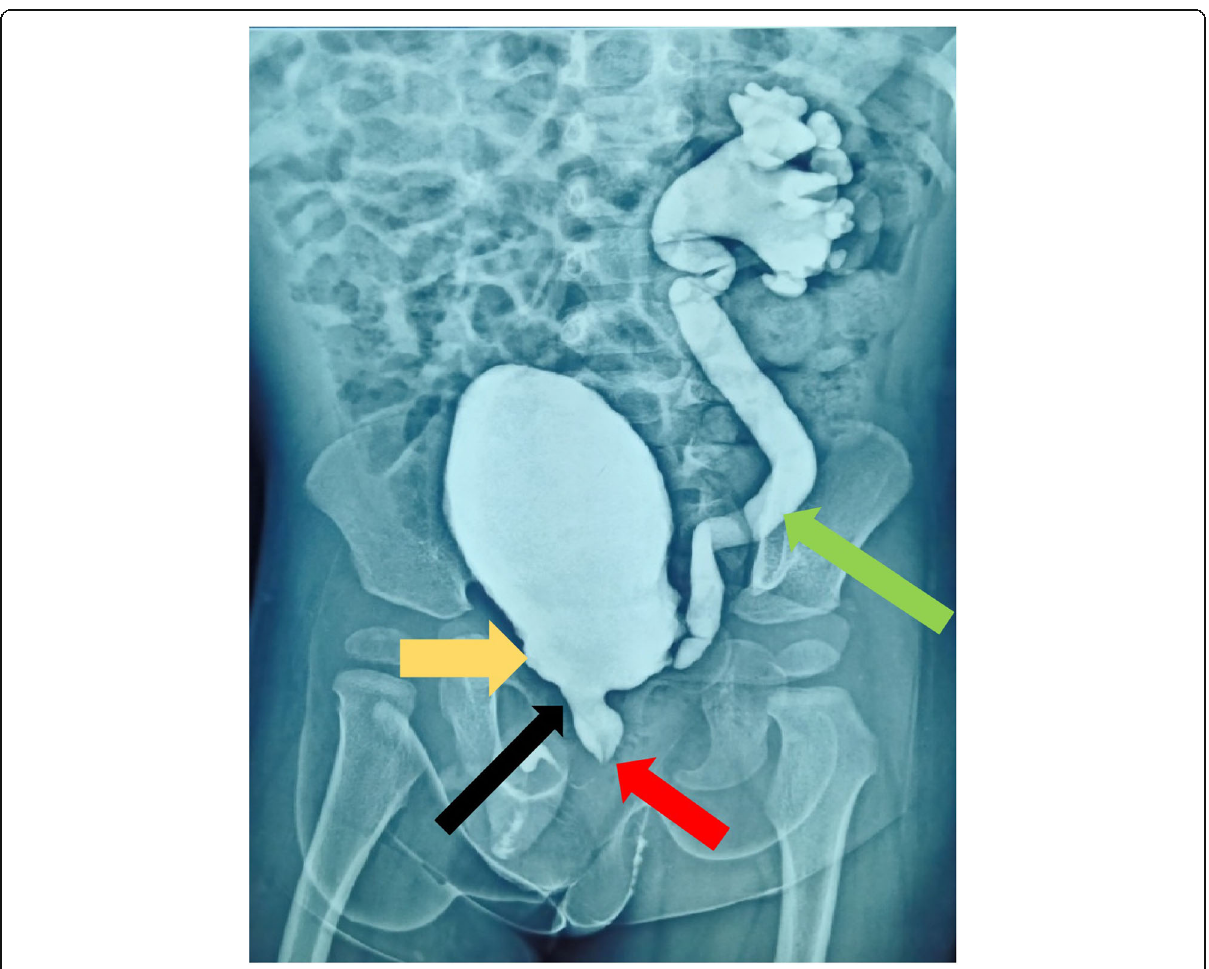
Fig. 2 Voiding cystourethrogram showing mildly dilated posterior urethra (red arrow), open bladder neck (black arrow), elongated bladder with trabeculation (yellow arrow), and left grade V vesicoureteric reflux (green